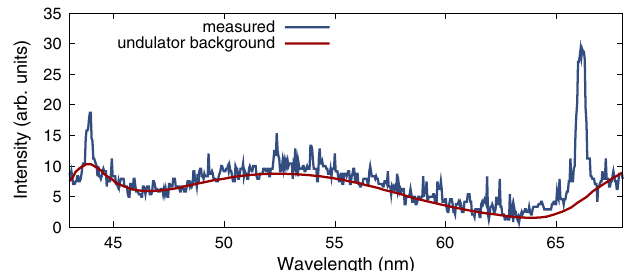
FIG. 4. A series of color coded single shots (a) and the average of them (b) recorded in the linear mode of the radiator at 66 nm. A single shot spectrum is plotted in the inset. The calculated incoherent undulator harmonics (light gray line) is fitted for the pulse energy calibration.